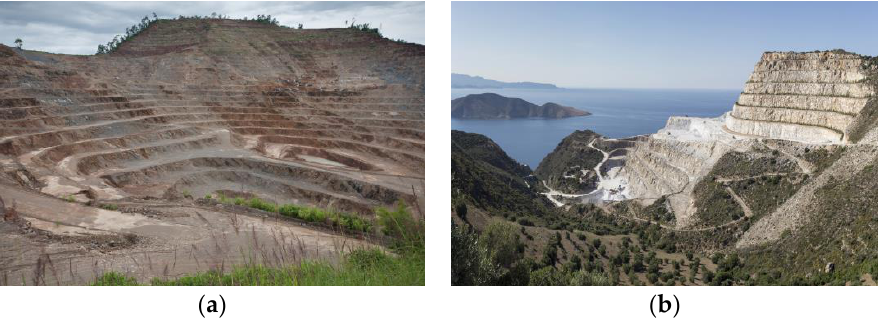
Figure 1. Examples of berms installed on actual slopes: ( a ) Slopes with berms in Thailand (Roengrit Kongmuang/Shutterstock.com; accessed on 9 March 2021); ( b ) slopes with berms in Crete, Greece (Gestiafoto/Shutterstock.com; accessed on 9 March 2021).